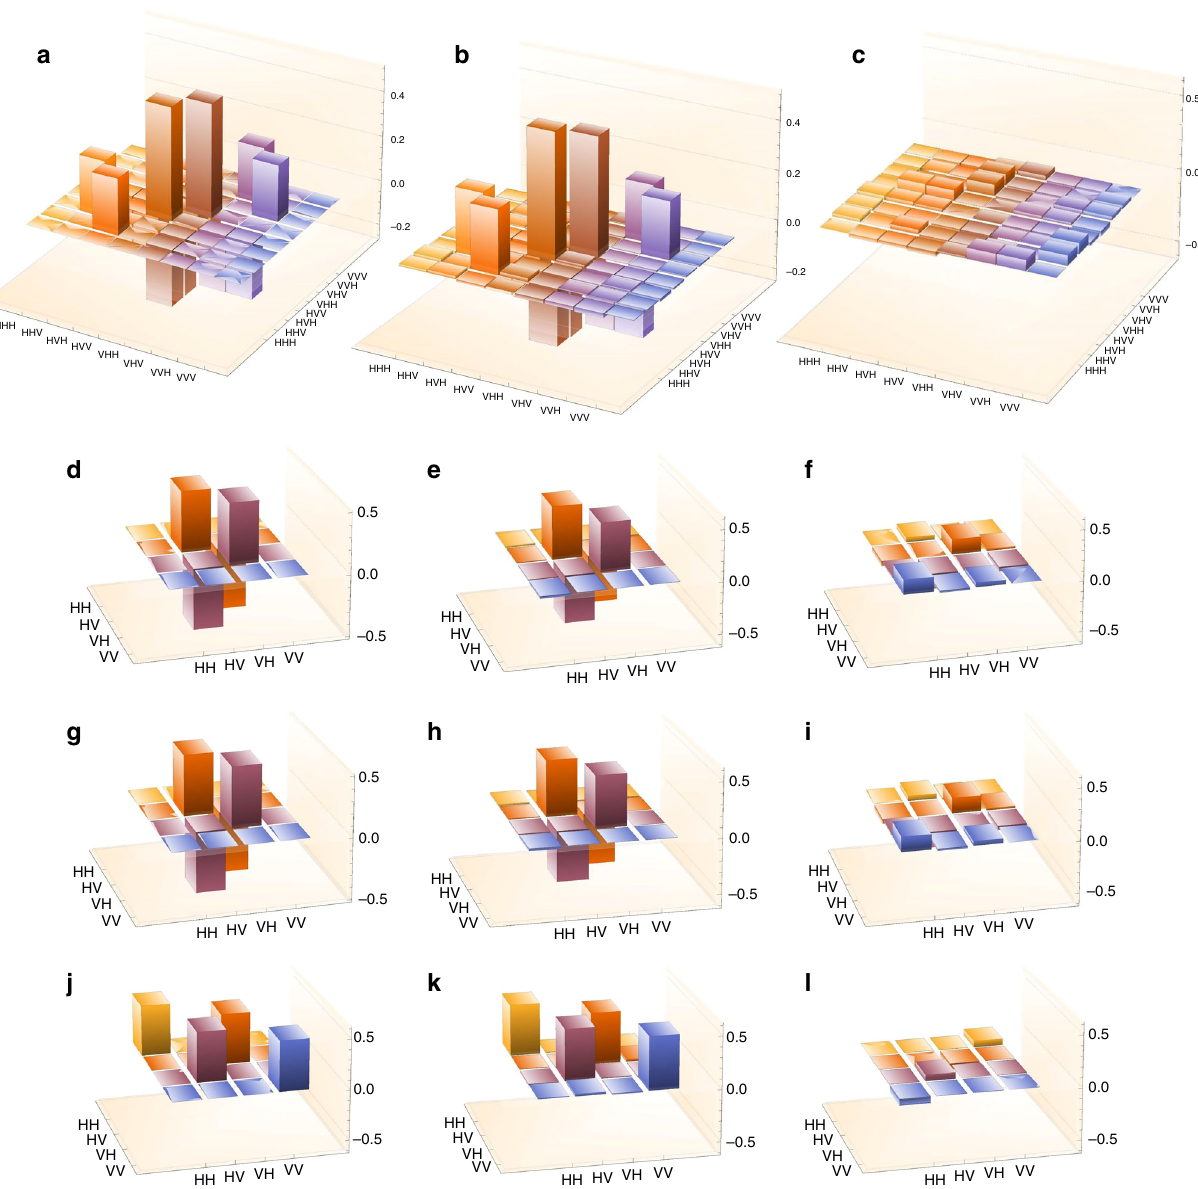
Fig. 3 Pseudo-density operator tomographic reconstruction. Theoretical R 123 PDO ( a : since Im[ R 123 ] = 0, we only plot Re[ R 123 ]) compared with the real ( b ) and imaginary ( c ) part extracted by quantum state tomography. Below, theoretical models of the R 12 , R 13 and R 23 marginals (plots d , g and j , respectively) compared with the real (plots e , h and k ) and imaginary (plots f , i and l ) part of their tomographically reconstructed counterparts. Again, since in our model Im[ R 12 ] = Im[ R 13 ] = Im[ R 23 ] = 0, the corresponding theoretical plots have been the two 'physical' PDO marginals R 12 and R 13 , that is, F 12 = 0.964 and F 13 = 0.963 (where F ij is the fi delity of the R ij density matrix with respect to the theoretically expected singlet state).